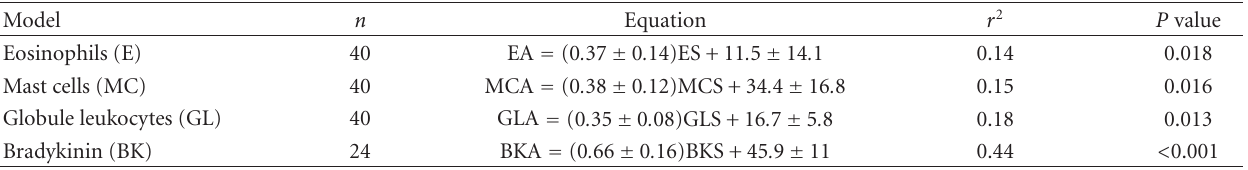
Table 1: Regression models for the relationship between granulocytes and bradykinin in the abomasum (A) and small intestine (S). Model